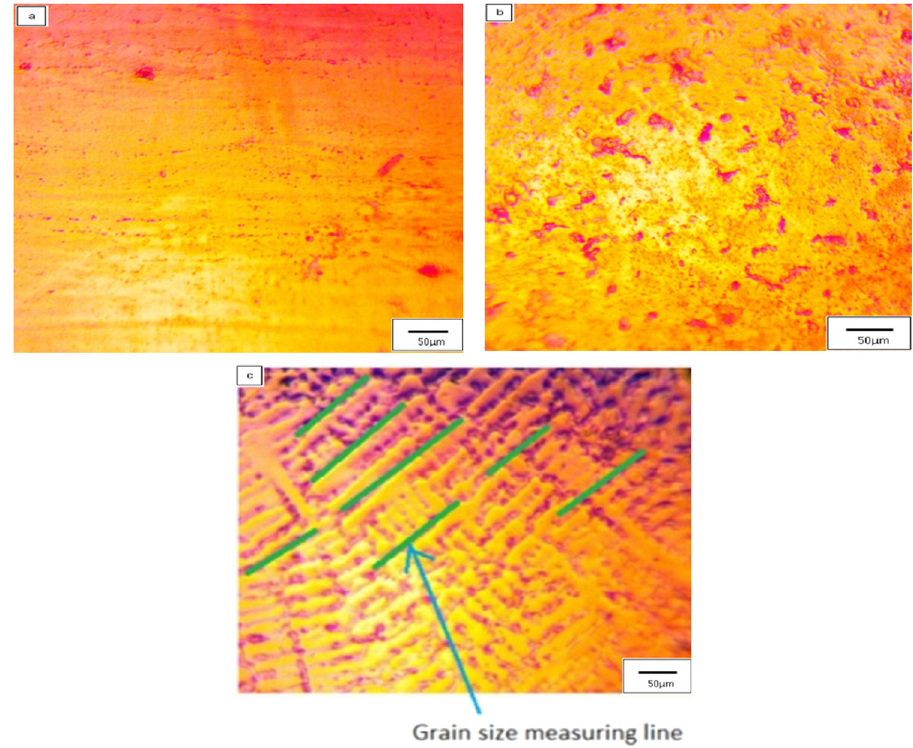
Figure 3: Microstructures at various locations on weld zone: ( a ) base metal, ( b ) HAZ and ( c ) fusion